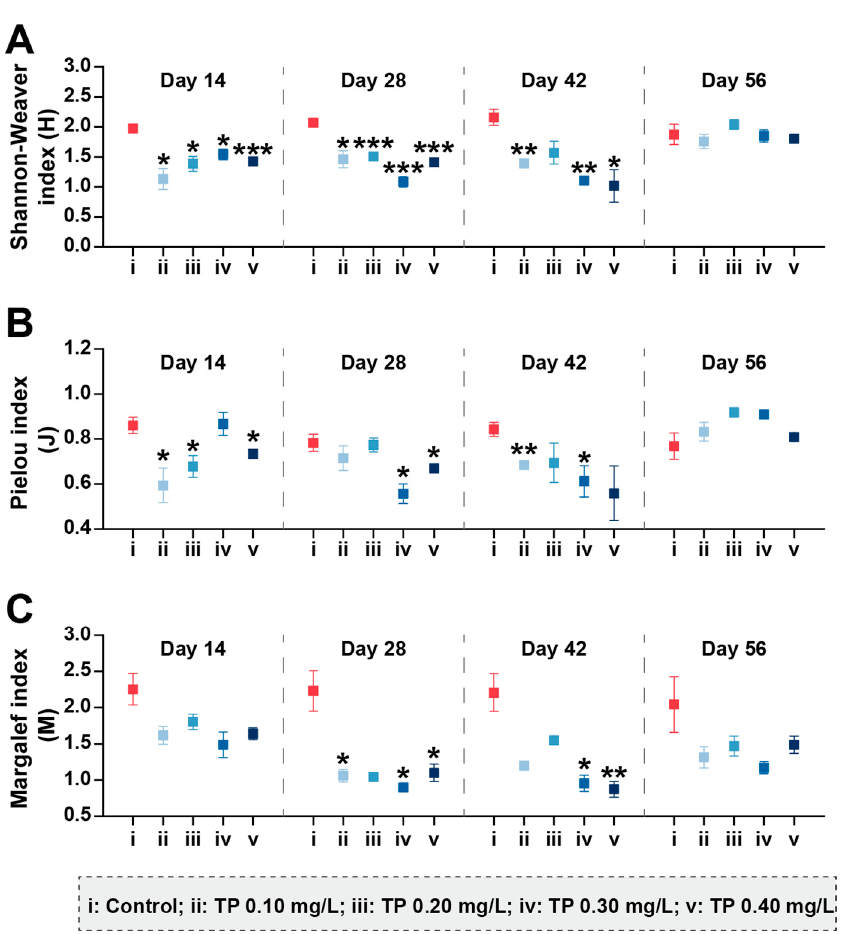
Figure 5. Shannon–Weaver diversity ( A ), Pielou evenness ( B ), and Margalef richness ( C ) of zooplankton communities under different TP concentrations. Significant differences are indicated in the figure, p ≤ 0.05 is marked as *, p ≤ 0.01 is marked as **, and p ≤ 0.001 is marked as ***. The PRC is significant ( p = 0.001) and 28.44% of the total variance in the zooplankton dataset is explained by treatment and 52.54% by the factor time (Figure 6A and Table S2). Statistically significant ( p ≤ 0.001) differences in zooplankton species composition between controls and TP enrichment treatments during the entire period of exposure. At the species-level, there was a generally significant increasing trend in the abundances of Monostyla pyriformis and Alona rectangular in TP enrichment treatments. In contrast, the abundance of Pompholyx complanate showed a significant downward trend (Figure 6B).